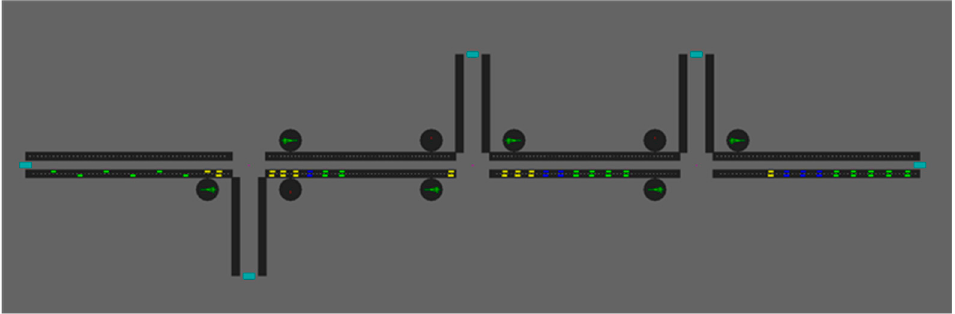
Figure 6. A sample coordinated corridor.